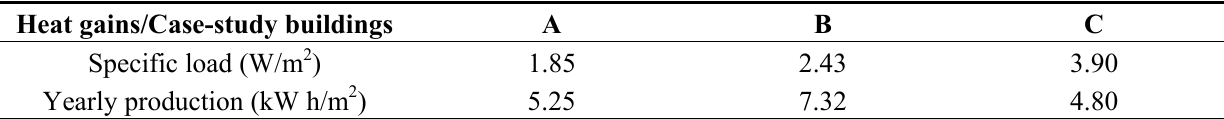
Table 8. Heat gains due to the presence of people for the case-study buildings (yearly productions evaluated by TRNSYS 16) [7,8].